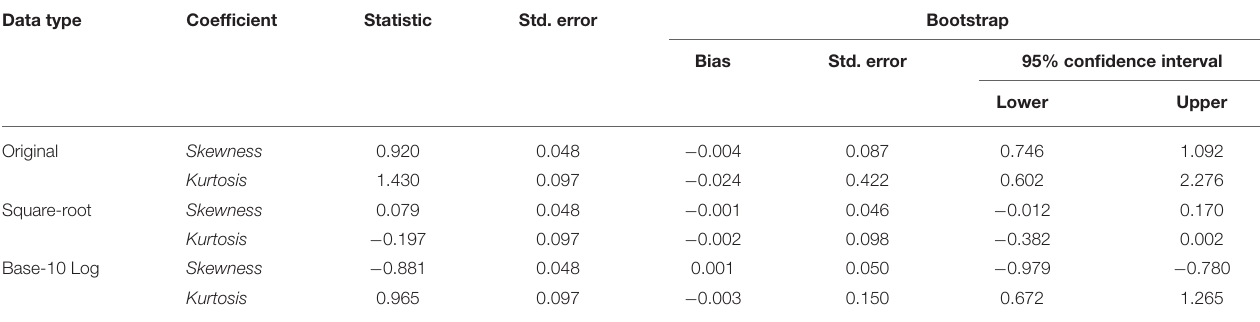
TABLE 2 | Students’ depressive symptoms data normality tests.